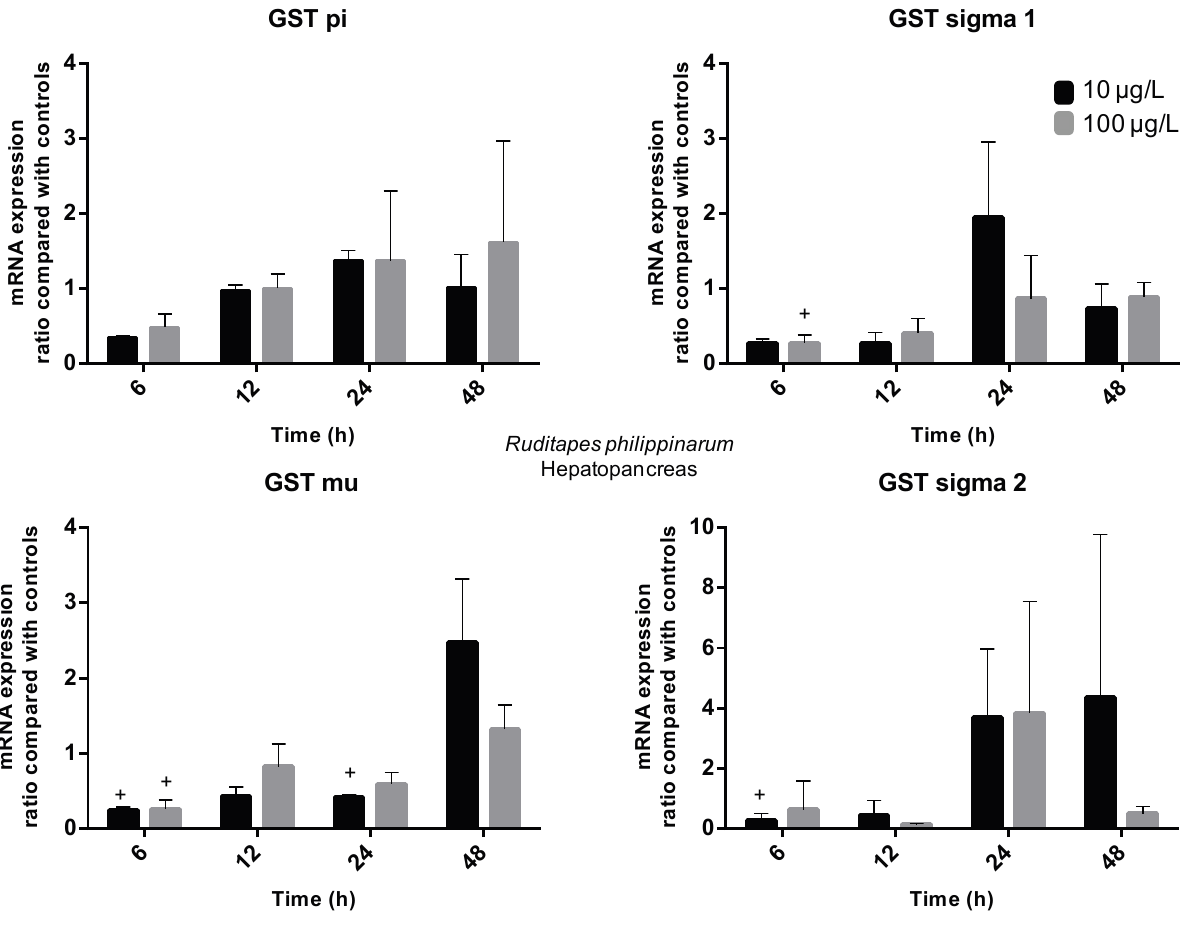
Figure 3. Temporal changes of R. philippinarum hepatopancreas GSTs transcripts after pure MC-LR exposure compared with controls (Treatment group ratio/Ctrl ratio). Black columns represent low-exposure group (10 µg/L MC-LR) and grey columns represent high-exposure group (100 µg/L MC-LR) (statistically significant differences were accepted at p ≤ 0.05; + indicates differences to